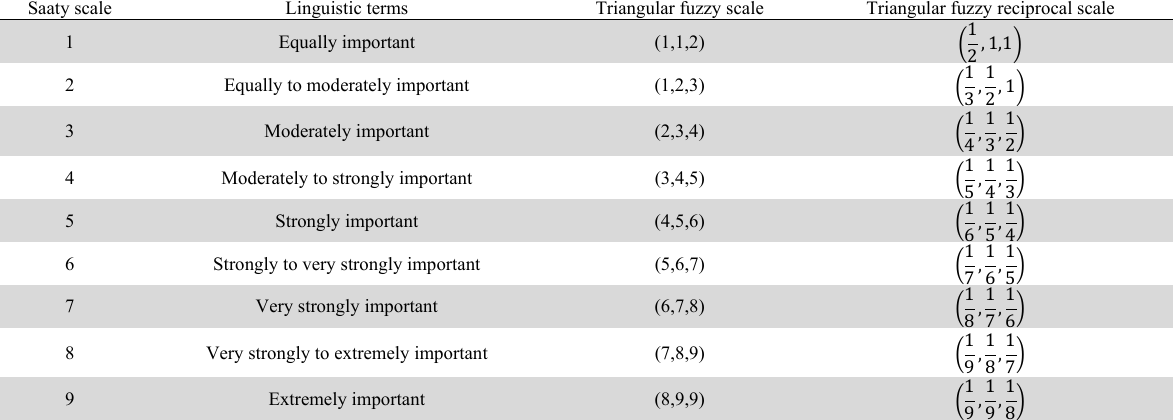
Saaty’s fuzzifying scale (Saaty